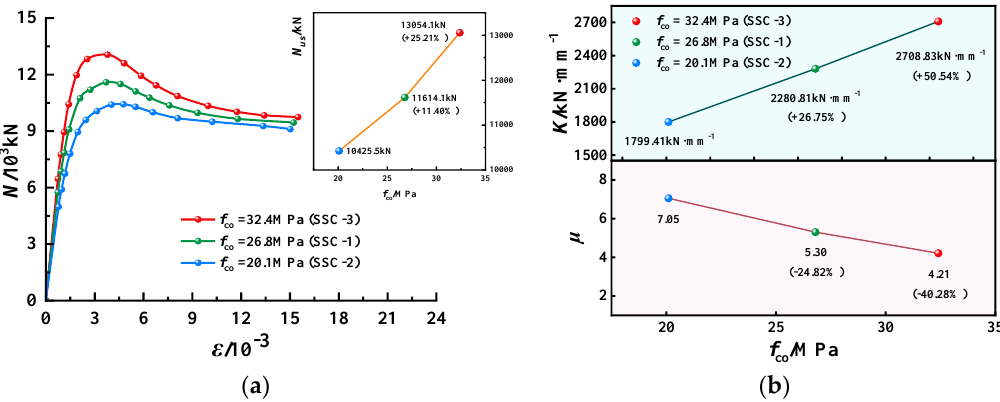
Figure 9. N - ε curves, K and µ of EGCSSCs with different f co : ( a ) N - ε curves of specimens with cross-section height of 800 mm. ( b ) K and µ of specimens with cross-section height of 800 mm.